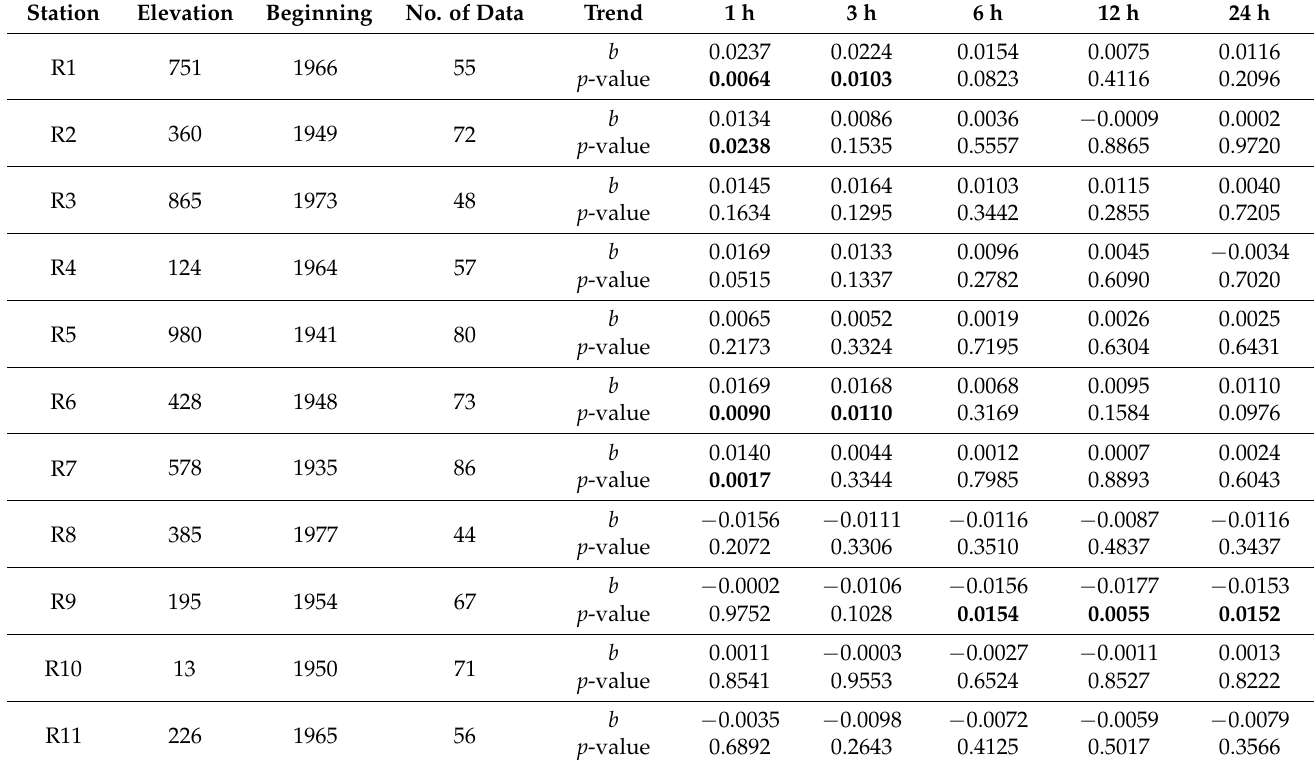
Table 6. Results of the least squares linear regression test applied to the time series of annual maxima of rainfall of the 11 considered rain gauges. Elevation (in m a.s.l.) of the rain gauge, the starting year of the time series and the number of available data are reported in table. The parameter b (in σ /year, where σ is the standard deviation) is the slope of the regression line; statistically significant trend line slopes ( p -value < 0.05) are shown in